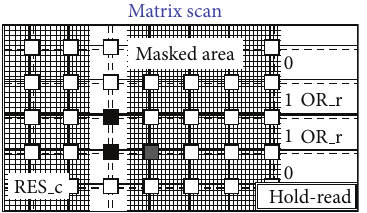
Figure 11: Second enabled column.